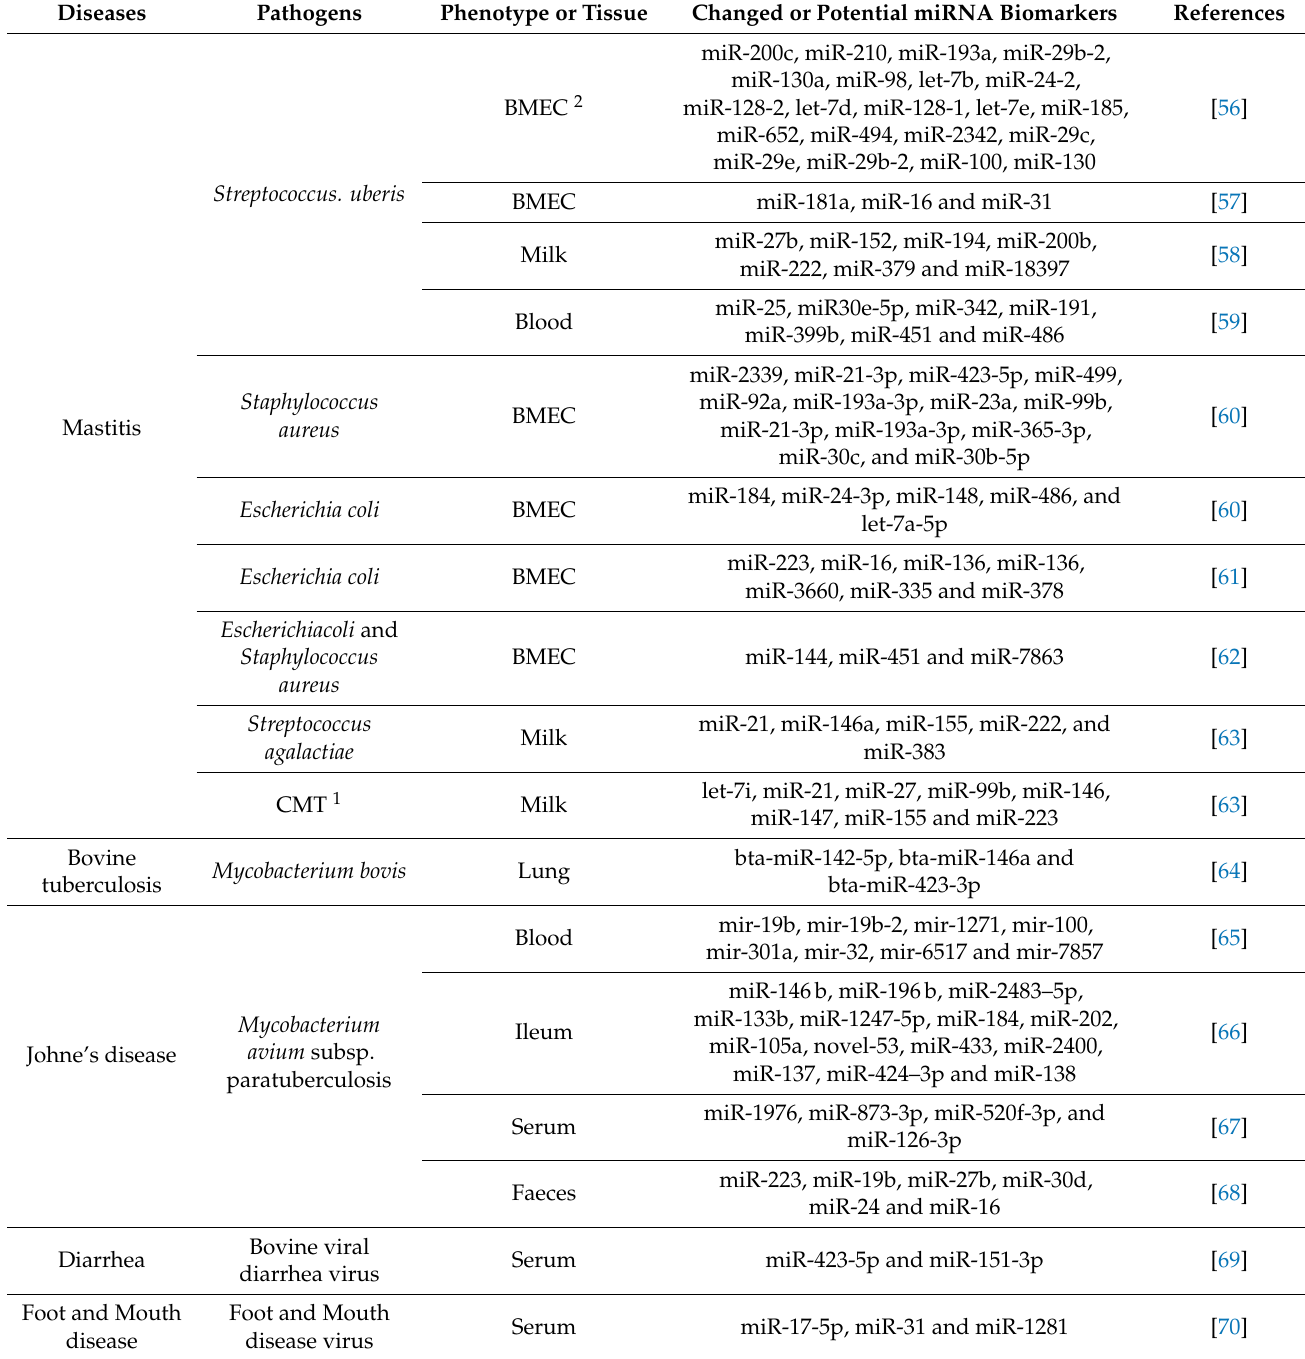
Table 2. Important miRNAs for bovine